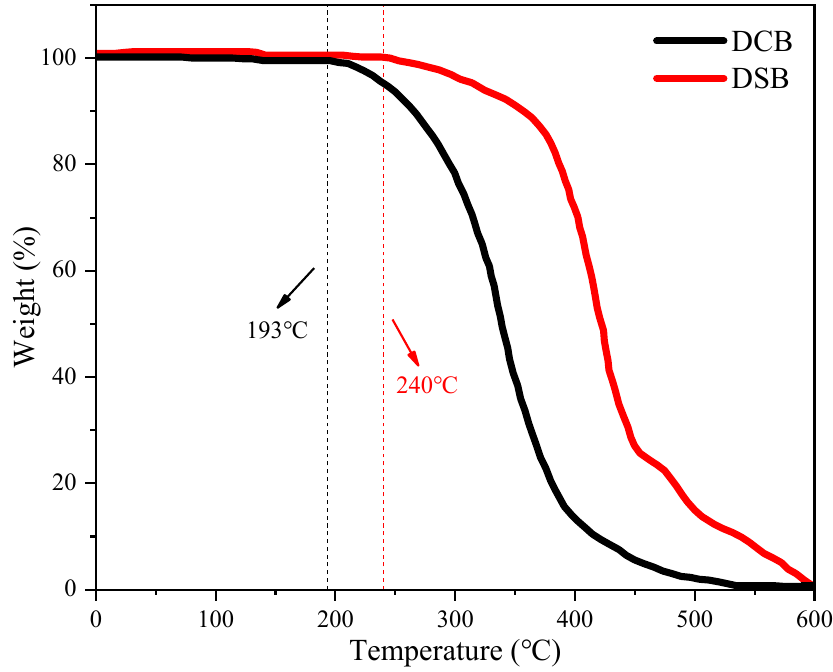
Figure 1. TGA curves of DCB and DSB.